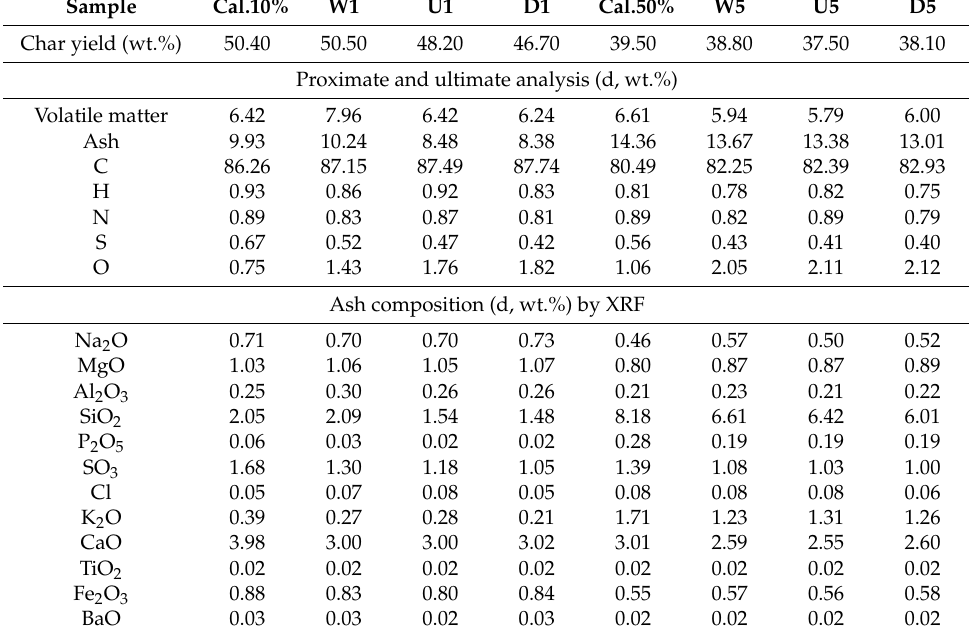
Table 2. Char yields and characteristics for co-pyrolysis of WS and HKN in the LPA reactor compared to calculated values, at 800 ◦